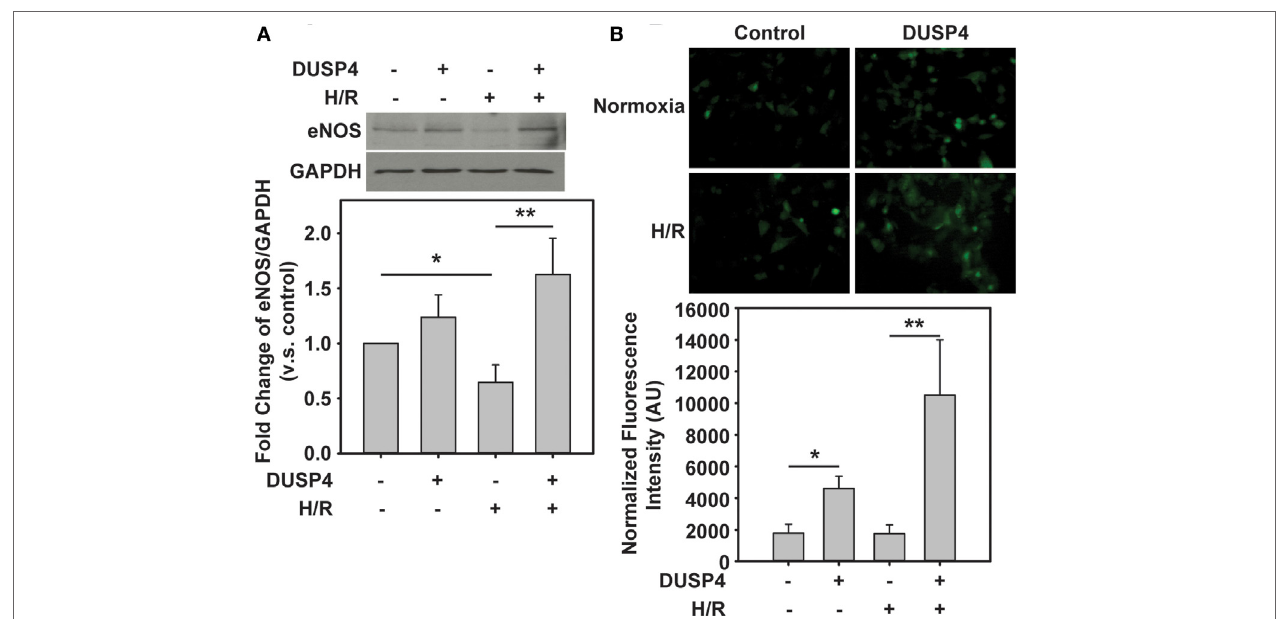
FigUre 4 | The beneficial effect of dual-specificity phosphatase 4 (DUsP4) overexpression via the upregulation of enOs . (a) Increased oxidant stress by H/R treatment contributes to eNOS degradation. DUSP4 overexpression upregulates eNOS expression and prevents it from H/R-induced protein degradation. Upper panel is the immunoblotting of eNOS. Lower panel is the immunoblotting of GAPDH as a loading control. (B) NO generation from bovine aortic endothelial cells was measured using DAF-2 and fluorescence microscopy in green. DUSP4 overexpressed in endothelial cells not only upregulates eNOS protein expression but also enhances NO generation. The increase in NO generation provides a beneficial effect for cell survival against H/R-induced oxidant stress. * and ** P < 0.05. Data are expressed as mean ± SEM, n ≥